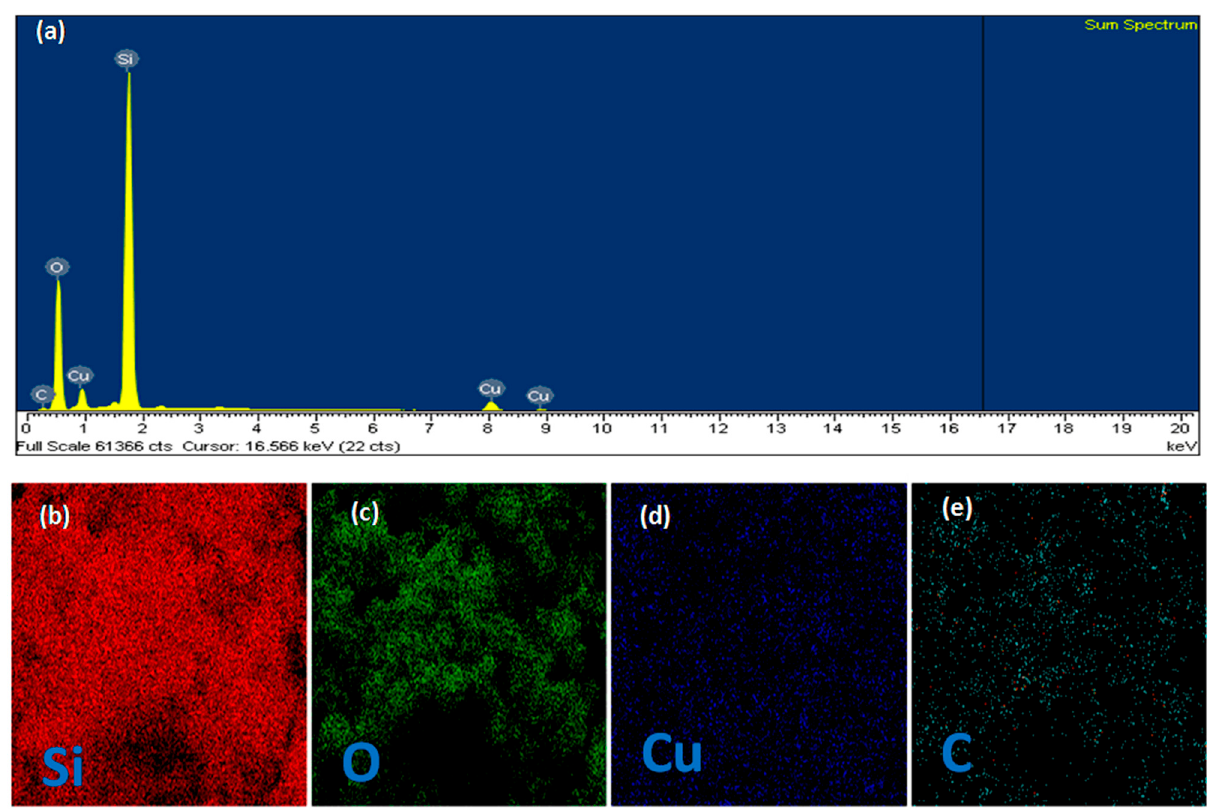
Figure 6. Typical EDX spectrum of SiO 2 @Cu@CMC NPs ( a ). EDX elemental mapping of Si ( b ), O ( c ), Cu ( d ) and C ( e ).